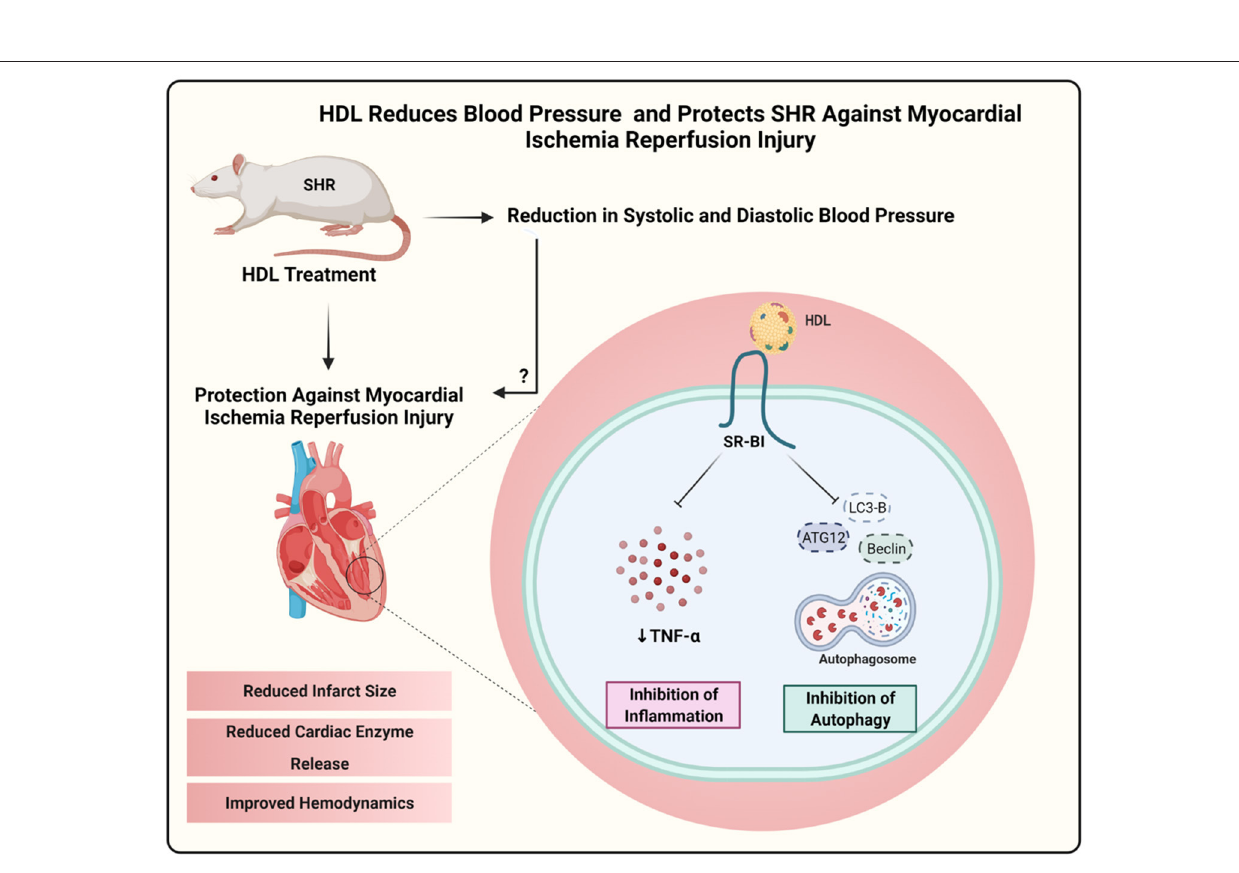
Frontiers in Cardiovascular Medicine |